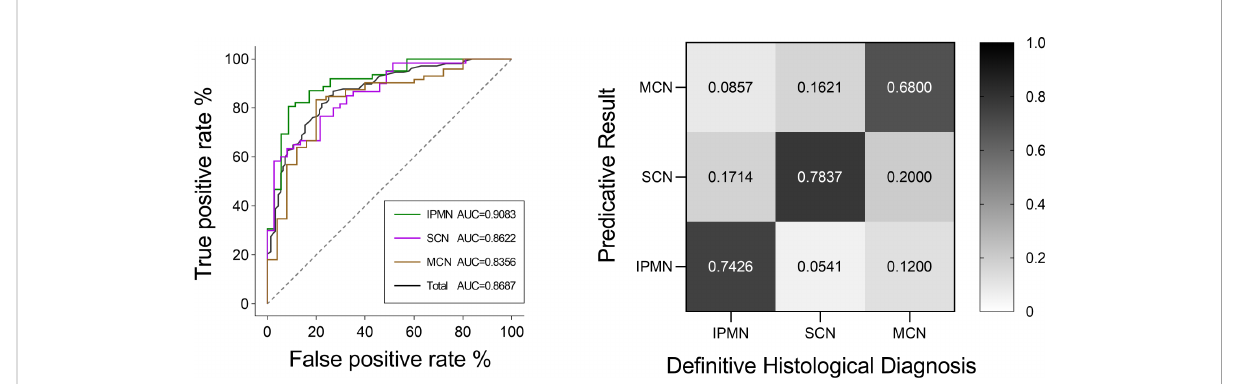
FIGURE 7 ROC curves of IPMN, SCN, and MCN and the total cases for the Model 6. The fi nal AUC values of IPMN, SCN, and MCN were 0.9083, 0.8622, and 0.8356, respectively. In addition, the mean AUC value of fi ve-fold cross-validation was 0.8687. ROC, receiver operating characteristic; AUC, area under the ROC curve. Relative confusion matrix of the three categories. Right color bar represents color coding of predicative rates from 0 to 1.